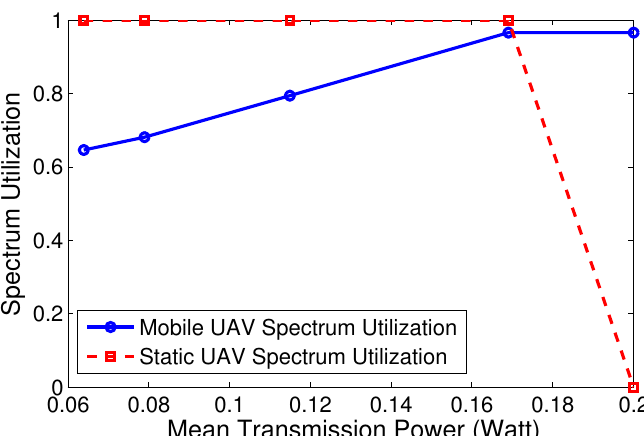
Figure 4. Average mobile and static spectrum utilization per mean transmission power investment.